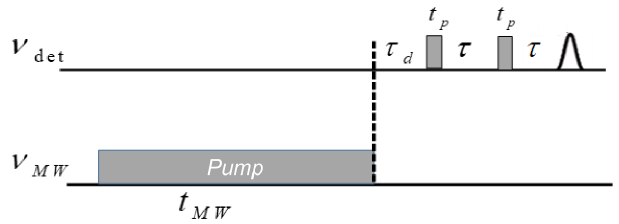
Figure 1. ELDOR pulse sequence, where ν det is the detection fre- quency, ν MW is the frequency of the pump pulse and t MW is the duration of the pump pulse.